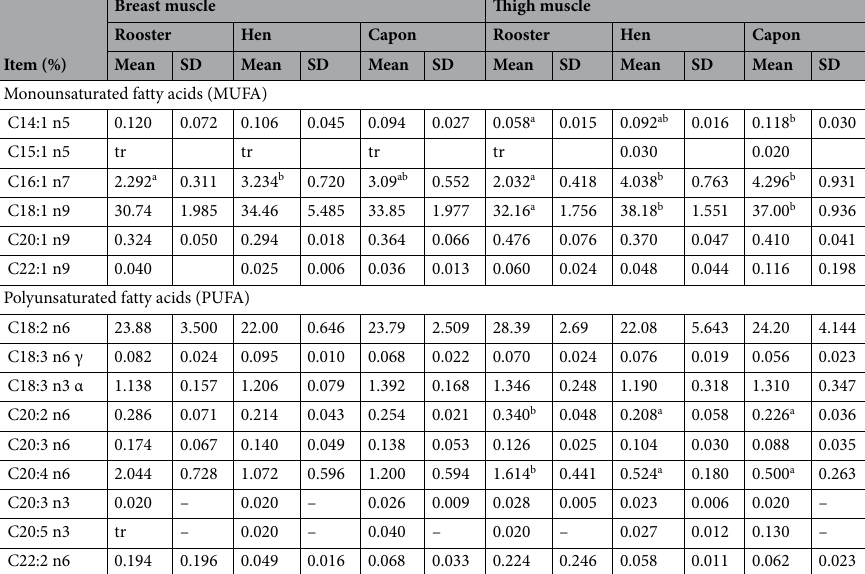
Table 3. Monounsaturated and polyunsaturated fatty acid profile of analysed muscles. a,b Mean values in the row (among particular muscle) differ significantly at p ≤ 0.05; SD standard deviation, C14:1—tetradecenoic acid, C15:1—pentadecenoic acid, C16:1—palmitoleic acid, C18:1—oleic acid, C20:1—gondoic acid, C22:1— nervonic acid, C18:2 n6—linoleic acid (LA), C18:3 n6- γ-linolenic acid (GLA), C18:3 n3- α—linolenic acid (ALA), C20:2n6—eicosadienoic acid, C20:3 n6- dihomo-γ-linolenic, C20:4 n6- arachidonic acid (AA), C20:5 n3—eicosapentaenoic acid, C22:2 n6- docosadienoic acid, tr- trace- content lower than